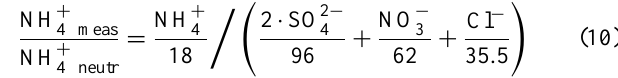
Fig. 1. Comparison of PM 1 chemical composition from AMS (organics (Org), sulfates (SO 2 − (Chl)) and black carbon (BC) measurements in the Paris